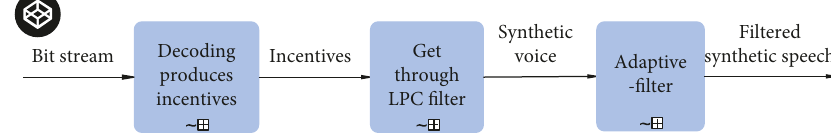
Figure 1: Adaptive postfiltering object of the conventional narrowband encoder.